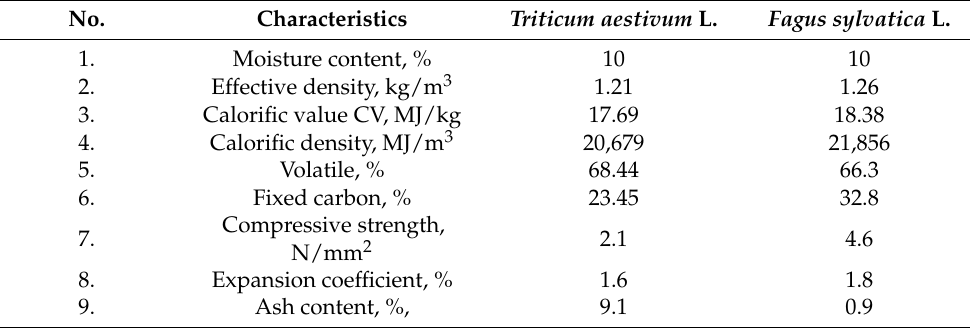
Table 3. Comparison between briquettes of wheat straw, T1, and European